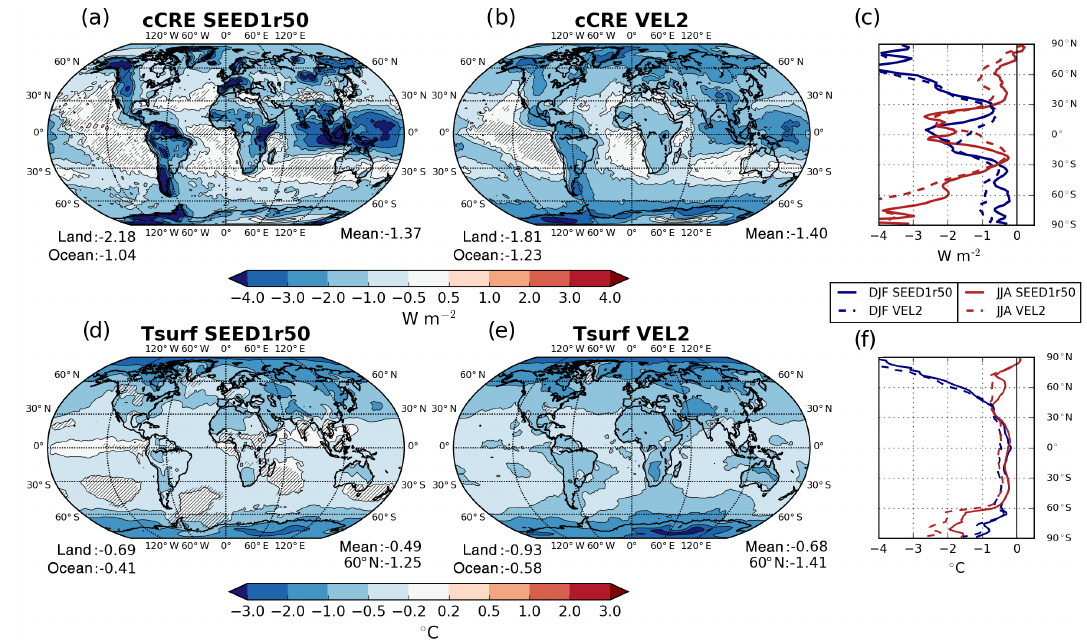
Figure 7. Annually averaged anomalies of cirrus cloud radiative effect (cCRE, a, b ) and surface temperature (Tsurf, c, d ) from the SEED1r50 and VEL2 MLO simulations. The hatching is applied for anomalies not significant at the 95% confidence level. Panels (c) and (f) show the respective annual zonal averages for DJF (blue) and JJA (red).